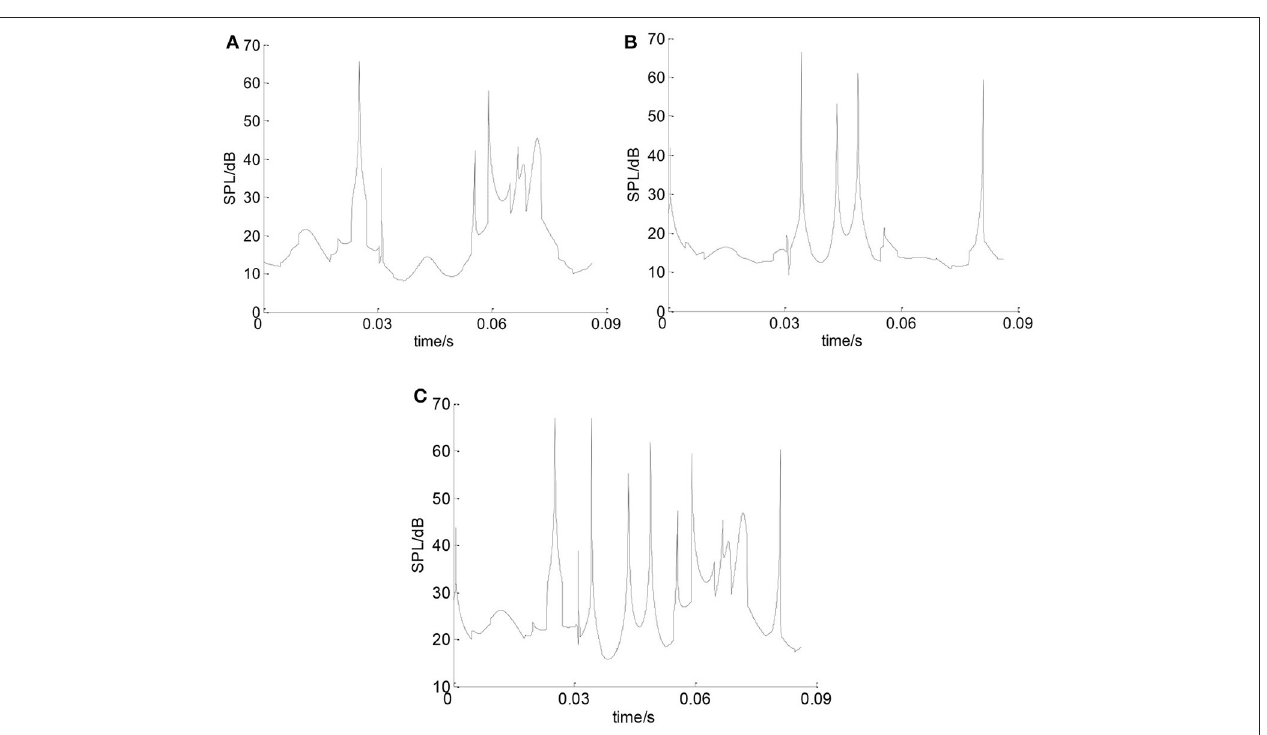
Frontiers in Mechanical Engineering |